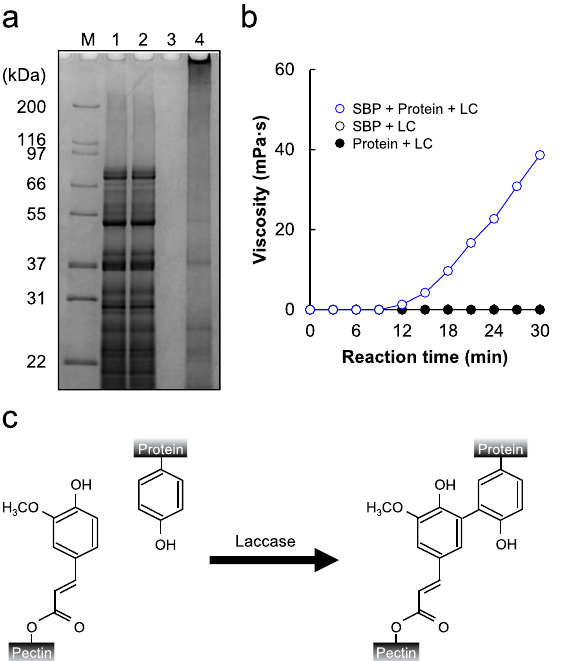
Figure 1. Synergistic effects of LC-catalyzed oxidative reaction on the formation of protein and SBP crosslinks. ( a ) SDS-PAGE analysis of soy protein and SBP treated with 100 U LC. Lane 1, non-treated soy protein and SBP; Lane 2, LC-treated soy protein; Lane 3, LC-treated SBP, Lane 4, LC-treated soy protein and SBP. Full-length SDS-PAGE gels are presented in Supplementary Fig. S1. ( b ) Apparent viscosity of soy protein and SBP solution treated with LC was measured using a viscometer. Open circle, LC-treated SBP; closed circle, LC-treated soy protein; blue circle, LC-treated soy protein and SBP. ( c ) Schematic of protein-SBP crosslink formation via LC-catalyzed oxidative